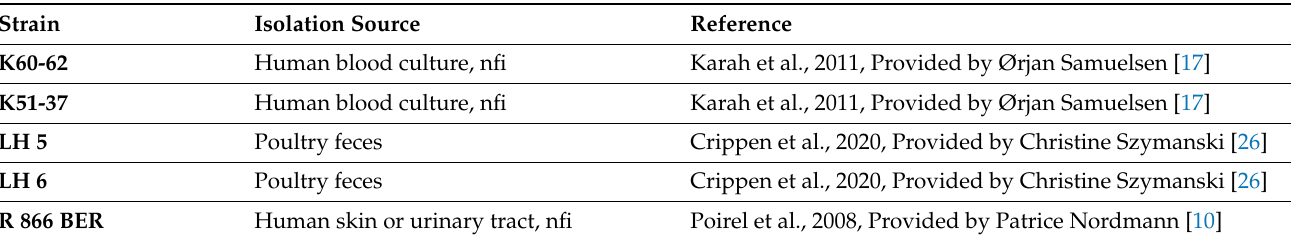
Table 2. Strains included from other